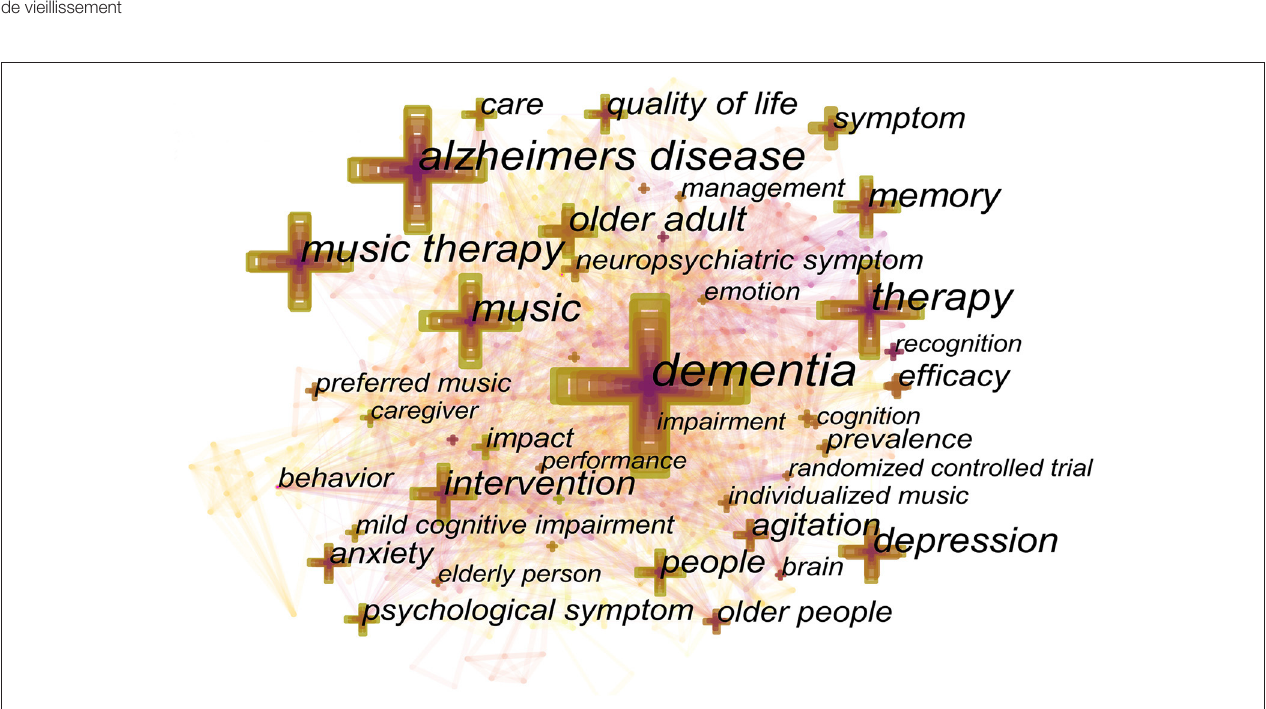
FIGURE 6 | Keyword co-occurrence